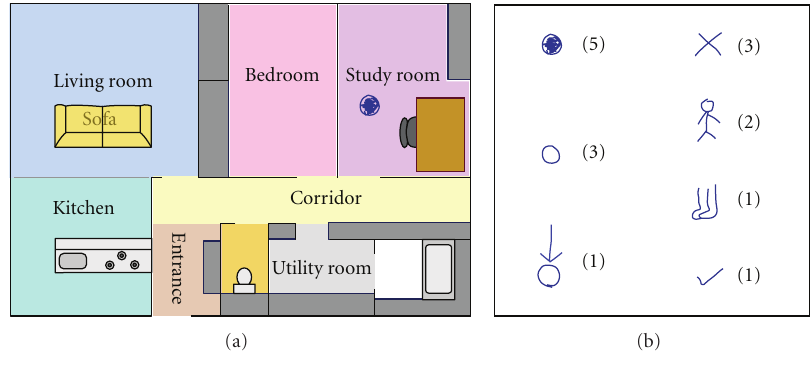
Figure 6: Sketch notations for staying at a